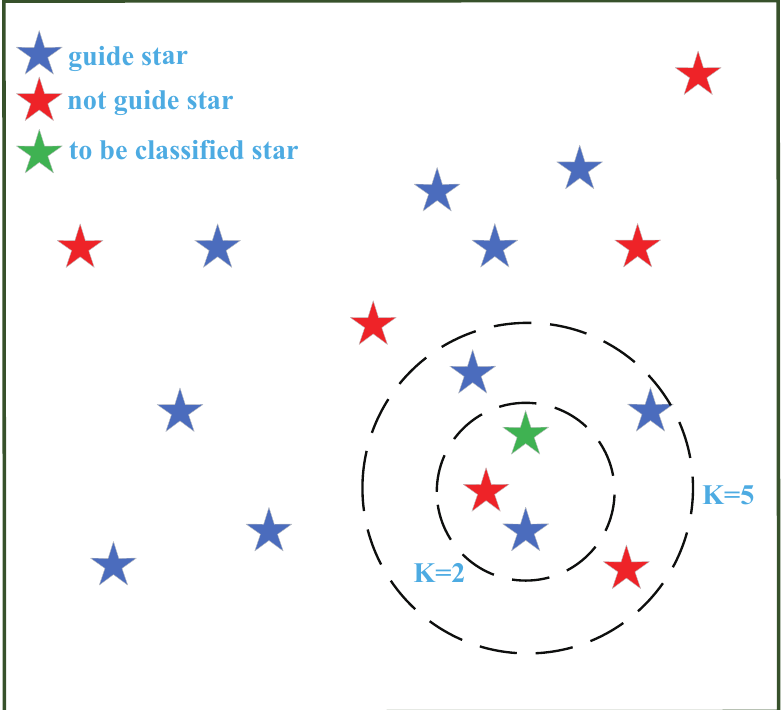
Figure 6. A schematic diagram of the KNN classification